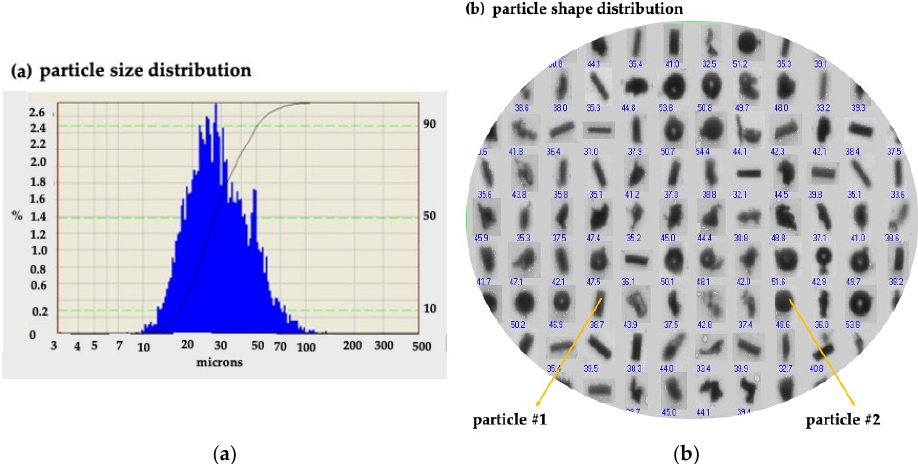
Figure 6. ( a ) PSD, ( b ) shape distribution, and selected particles have nearly the same size (modified from [34]).